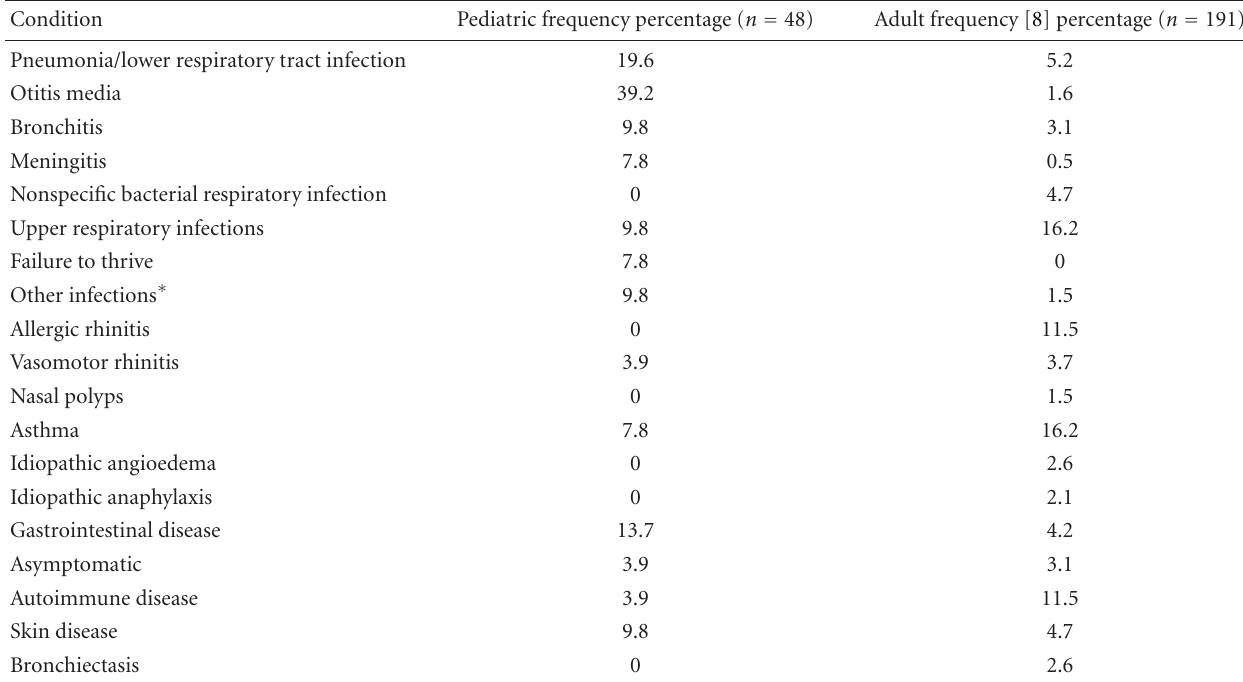
Table 2: Prevalence of presenting conditions in pediatric and adult patients with